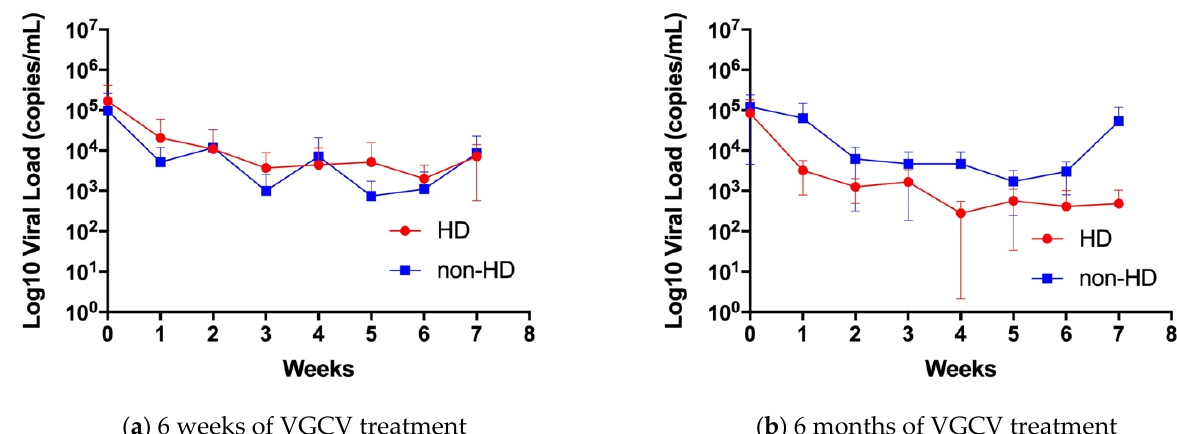
Figure 3. CMV viral load change in the whole blood of 6 weeks or 6 months of VGCV treatment groups. ( a ) Blood viral load change over 6 weeks of VGCV treatment, n = 7 in HD group, and n = 4 in non-HD group (1 missing data in week 7). ( b ) Blood viral load change over 6 months of VGCV treatment, n = 5 in HD group (1 missing data in week 7), and n = 4 in non-HD group (1 missing data in week 1 and 2 missing data in week 7). Red circle symbols represent HD group and Blue square symbols represents non-HD groups. Data are shown as mean ± standard deviation. HD; hearing dysfunction, non-HD; non-hearing dysfunction.